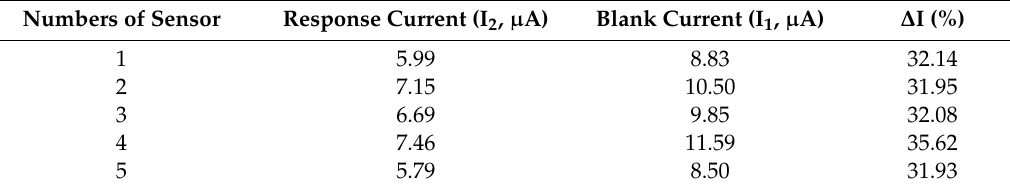
Table 2. Experimental results of sensor reproducibility.